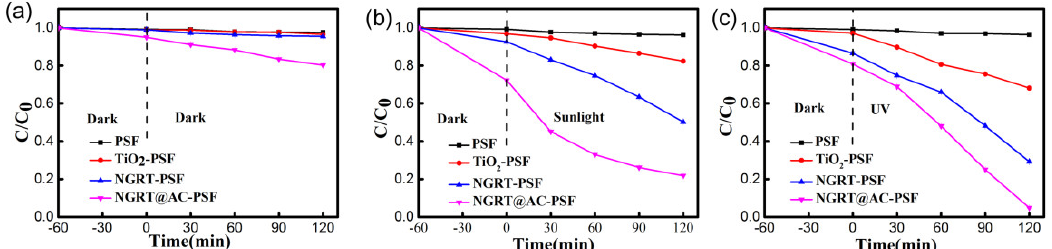
Figure 8. The photodegradation rate of MO solution in the as-prepared membranes under ( a ) dark, ( b ) sunlight, and ( c ) UV conditions. Condition: The effective area was 17.34 cm 2 , and the concentration and amount of MO solution were 30 mg/L and 150 mL, respectively.